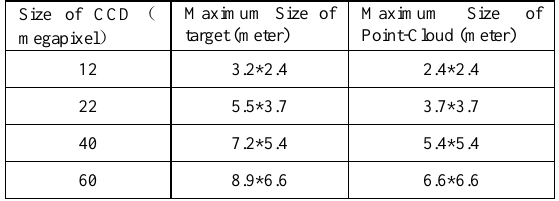
Table 2. Size of CCD and Point